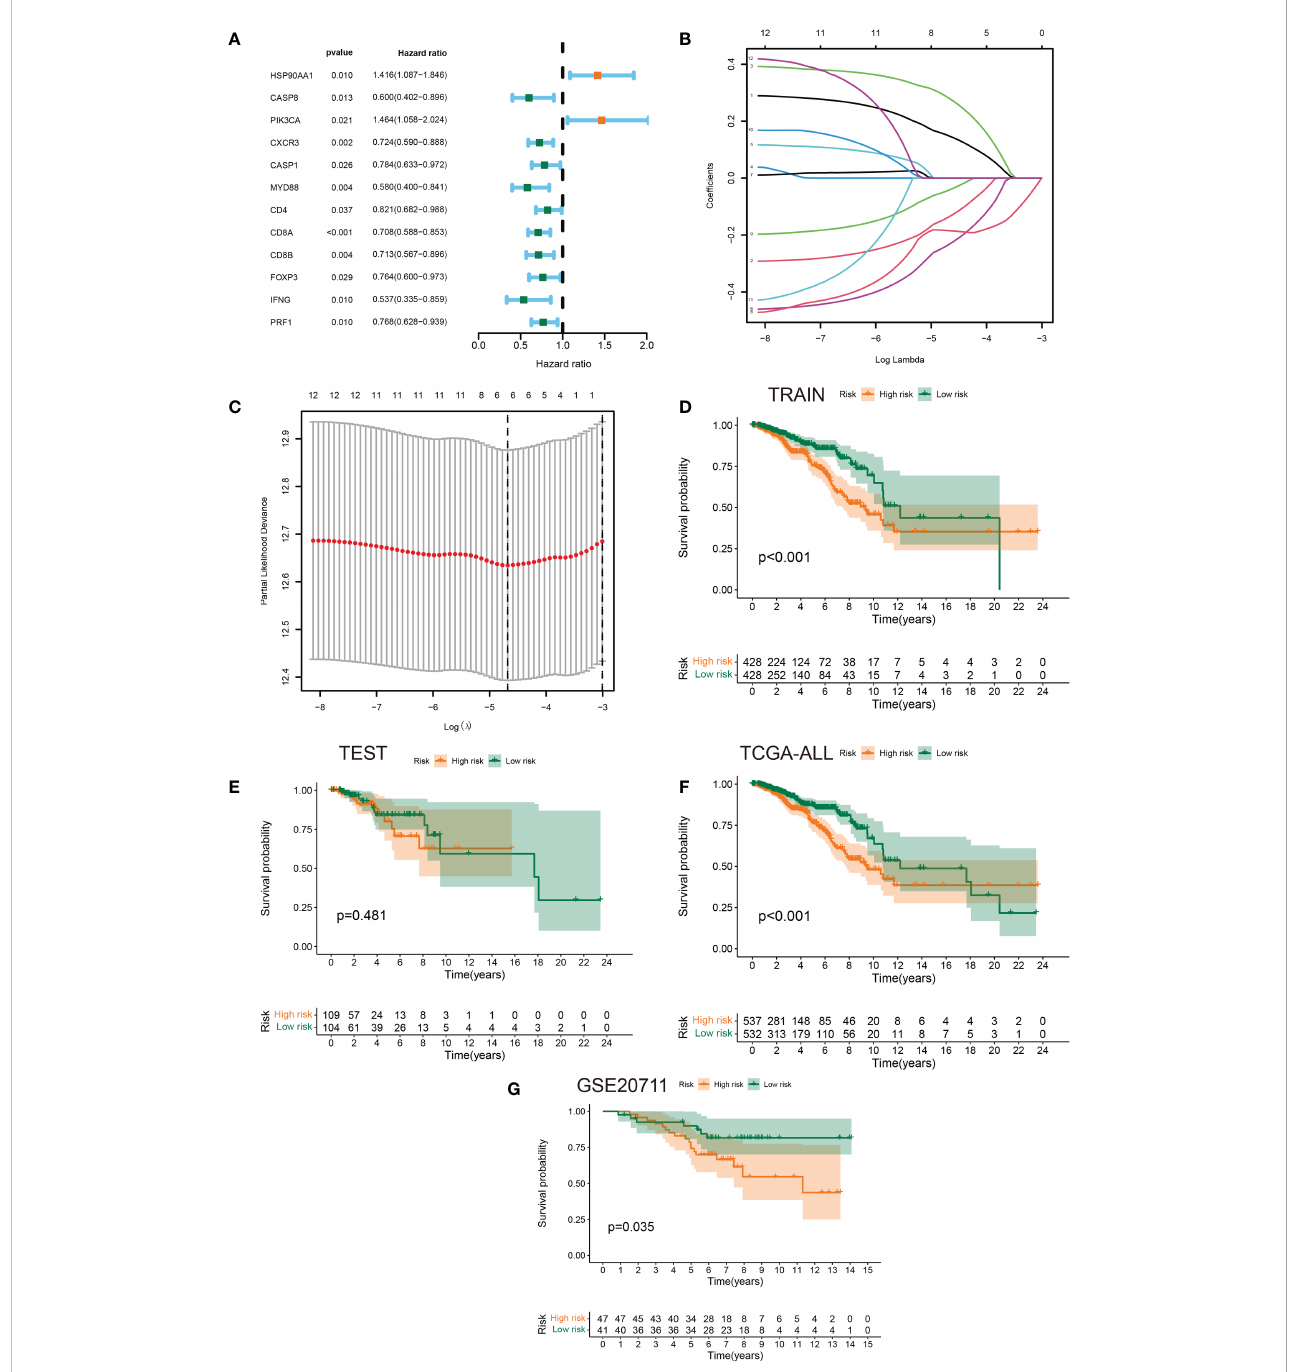
FIGURE 3 Identi fi cation of prognostic ICDRGs to establish a risk signature. (A) Forest plots of the results of the univariate Cox regression analysis of 12 prognostic ICDRGs in BRCA. (B, C) LASSO Cox regression analysis manifested that 6 out of the 10 ICDRGs were good candidates for constructing the prognostic signature. (D-G) Kaplan-Meier curves of patients in the high- and low-risk groups based on the 6 ICDRGs signature in the training set, test set, all TCGA cohort, and